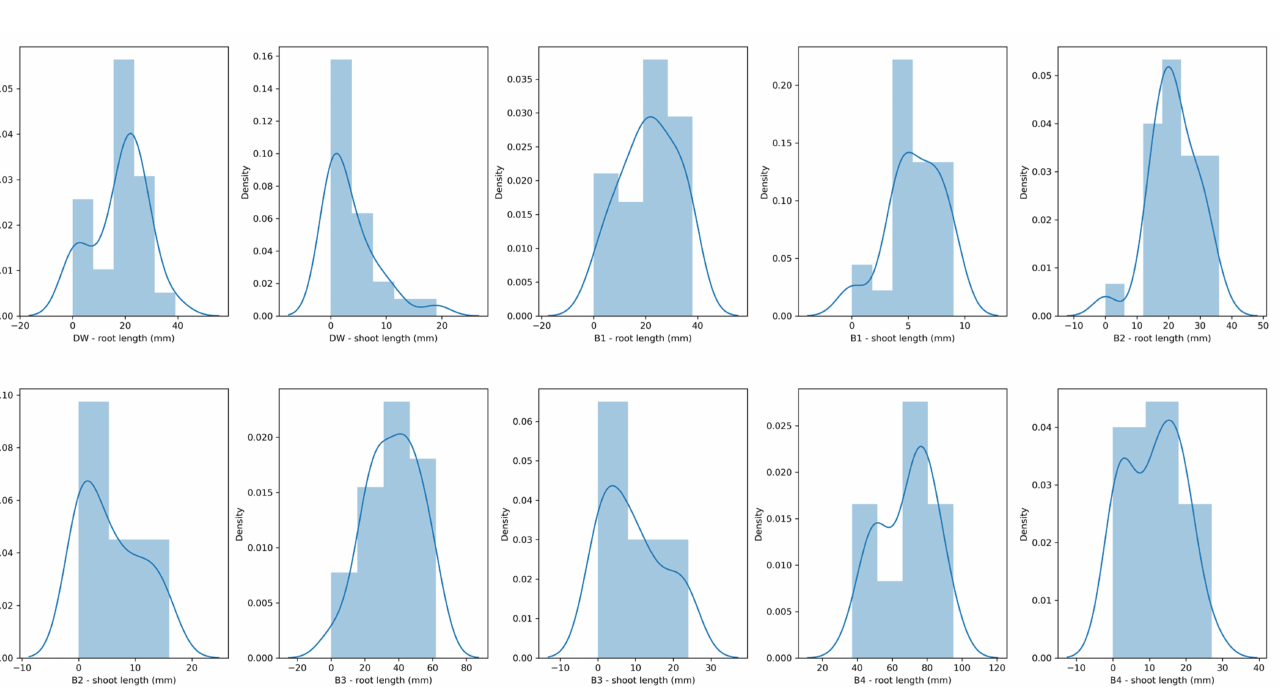
Figure 5. Distribution plots for root and shoot length of the germinated maize seeds treated with distilled water (DW) or Bacillus sp. BioSol021 cultivation broth samples produced under different cultivation conditions: B1: 0.5 vvm, 100 rpm; B2: 0.5 vvm, 300 rpm; B3: 1.5 vvm, 100 rpm; B4: 1.5 vvm, 300